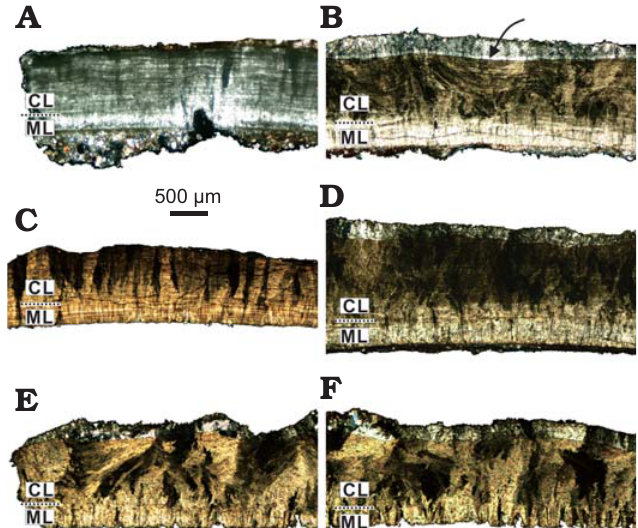
Fig. 3. Radial petrographic thin sections of eggshells from an adult-as- sociated clutch (A) from the Late Cretaceous of Bayan Mandahu, Inner Mongolia, China (Dong and Currie 1996) and the studied clutches (B–F) from the Late Cretaceous Nanxiong Formation of a construction site in Dayu County, Ganzhou City, Jiangxi Province, China. A . HGM- 41H-V0074. B . DM-2014-P0154. C . PFMM-0014002972. D . PFMM-0014004392. E . PFMM-0014003019. F . IVPP V9608. Dashed line, the ML/CL bound- ary; arrow, the calcite layer. CL, continuous layer; ML, mammillary